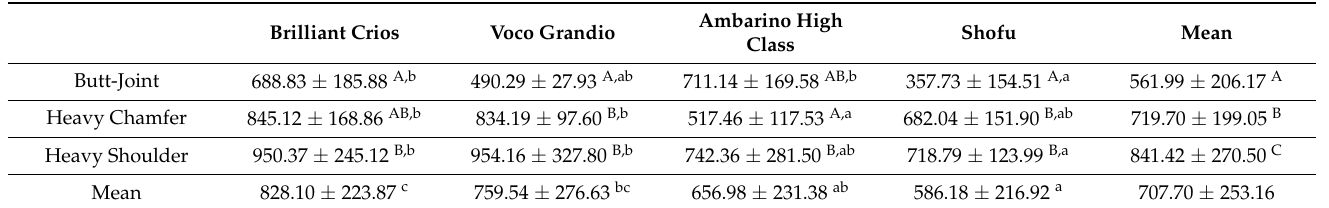
Table 3. Mean values and standard deviations of fracture resistance in Newtons (N) for test